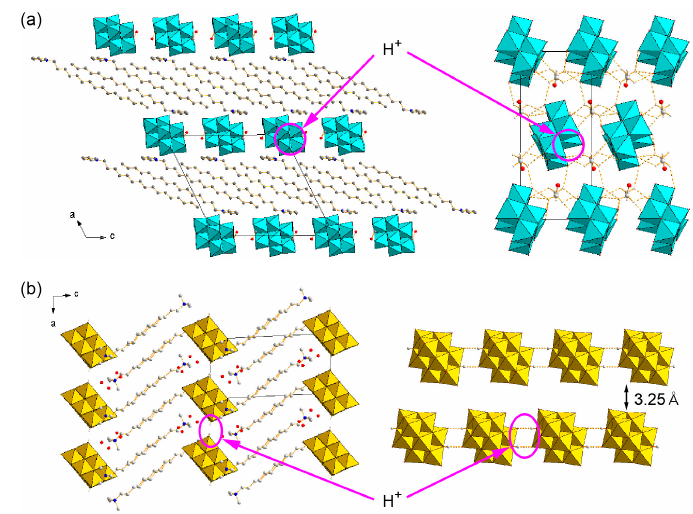
Figure 11. Proton-containing POM-surfactant crystals (left: crystal packing, right: molecular arrangement in the inorganic layer). ( a ) C 16 py- β -Mo 8 [122]; ( b ) C 10 NC 3 -V 10 [126]. Reproduced with permission from Mikurube, K. et al. , J. Chem.; published by Hindawi Publishing Corporation, 2013 and from Ito, T. et al. , Bull. Chem. Soc. Jpn. ; published by The Chemical Society of Japan, 2012.